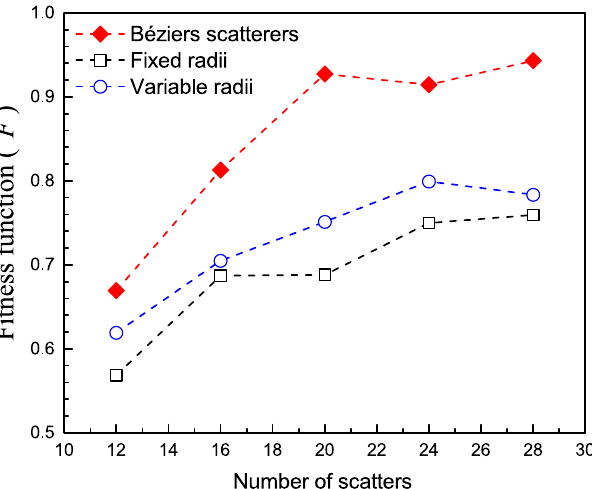
Figure 2. Dependence of the fitness function with the number of scatterers contained in the cloak. Three type of scatterers have been considered in the optimization procedure: Bézier scatterers (diamond symbols), scatterers with circular sections of equal radii (hollow squares) and scatterers with circular sections but variable radii (hollow circles). F = 1 means perfect concealing of the central object.